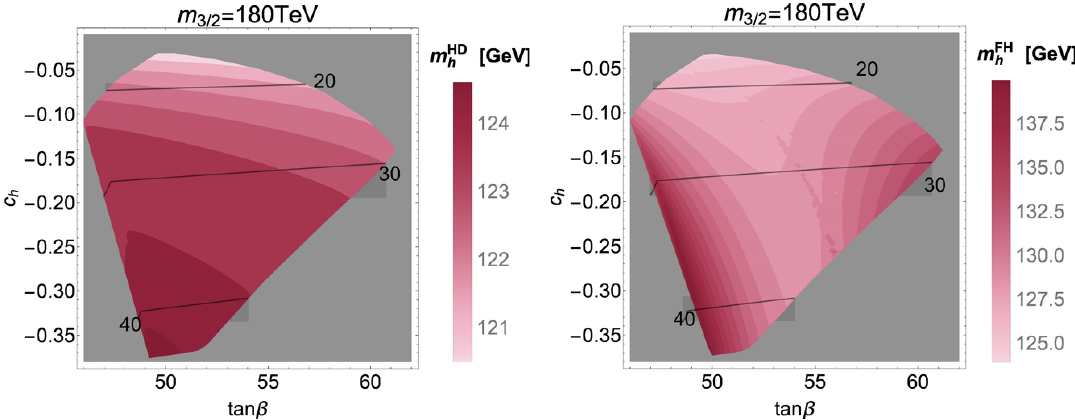
Figure 1 . Contour plots of the Higgs boson mass [GeV] calculated using SUSYHD (left) and FeynHiggs (right). We take m 3 = 2 = 180 TeV. The stop mass scale is also shown in units of TeV. Here, (cid:11) s ( m Z ) = 0 : 1185 and m t (pole) = 173 : 34